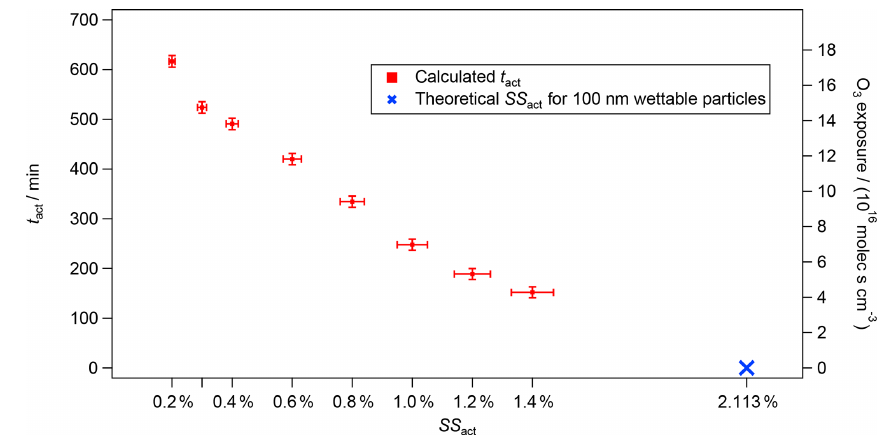
Figure 3. t act (left axis) and O 3 exposure (right axis) versus theoretical (blue cross) and experimental (red markers) SS act for the experiment from 5 August 2016 with CBW and O 3 (200ppb). The vertical bars represent the total error of t act of ± 12min, which originates from the instrumental errors of the CPC and CCNC. The horizontal bars show the 5% uncertainty in the SS of the CCNC (Rose et al.,